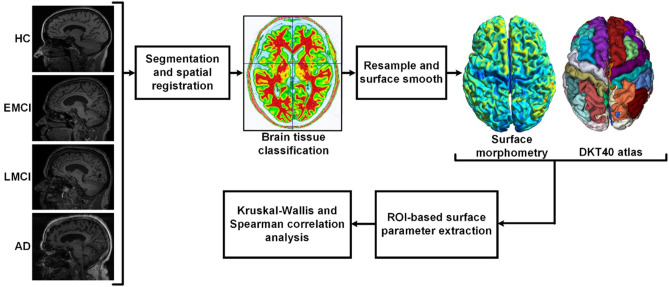
Flowchart of the regions-of-interest (ROI)-based surface morphometry analysis. After brain extraction and segmentation (white matter, gray matter, and cerebrospinal fluid), spatial normalization was performed to correct the orientation and the size of the brain. Then, the surface of gray matter was resampled and smoothed. The ROI-based surface parameters were extracted according to the DKT40 parcellation atlas. Cortical thickness, gyrification index (GI), and sulcus depth were used to characterize the deterioration patterns of gray matter during Alzheimer's disease (AD) progression.